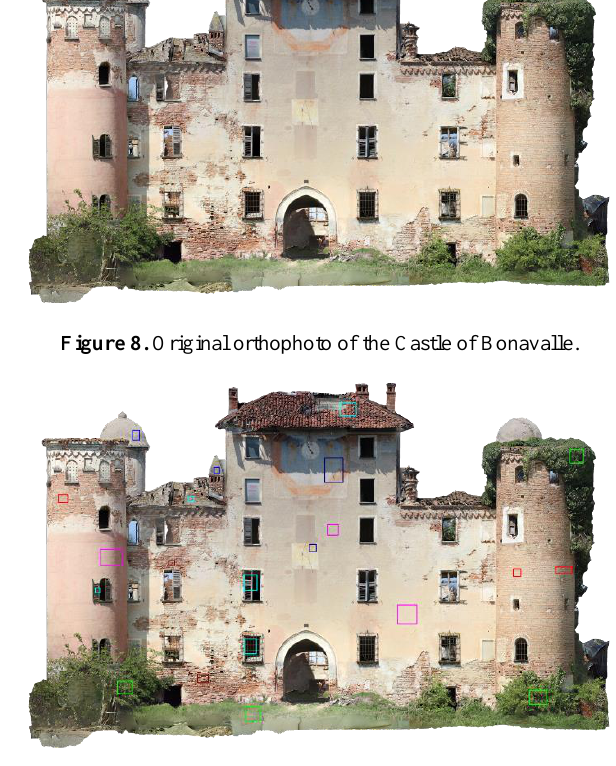
Figure 9. Training areas selected by the user through the user interface. Legend: magenta =plaster, navy =fresco, red =brick, brown =brick with lacks, blue =stone, lime =vegetation, cyan